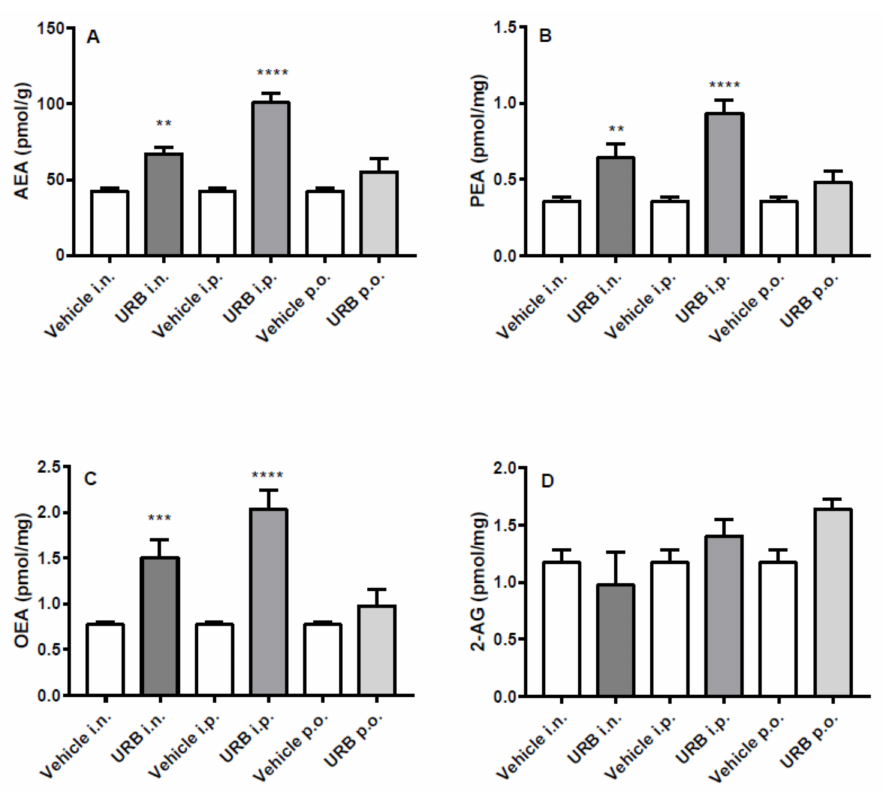
Figure 4. E ff ect of in vivo URB administration on cortical levels of NAEs and 2-AG. Levels of ( A ) AEA, ( B ) PEA, ( C ) OEA and ( D ) 2-AG following URB or vehicle (i.n., i.p. or p.o.) administration. Data are presented as mean ± SEM expressed as pmol per gram or milligram of wet tissue. ** p < 0.01, *** p < 0.001 and **** p < 0.0001 post hoc comparisons with vehicle conditions, Tukey’s